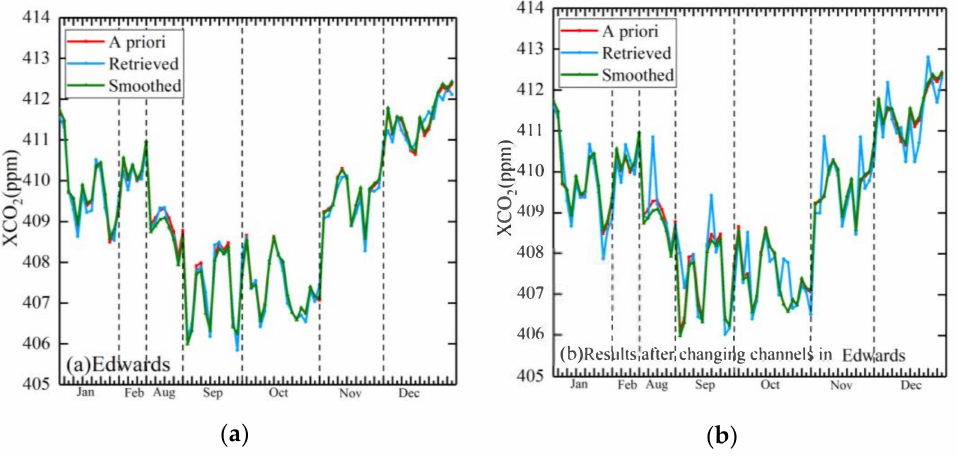
Figure 12. Comparison of Edwards observations with inversion results ( a ) and inversion results using channels in opposite seasons ( b ). Red line is for a priori, blue line is for CrIS inversion, and green line is for the smoothed TCCON